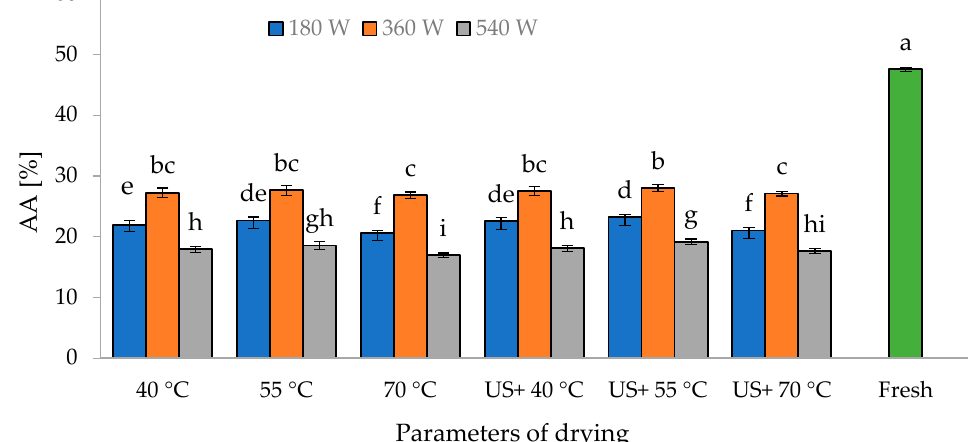
Figure 8. Effects of US pretreatment, MW power and air temperature during drying on antioxidant activity (AA) in hawthorn. Data followed by different letters (a–i) in each column are significantly different at p < 0.01. Columns with the same letters are not significantly different.